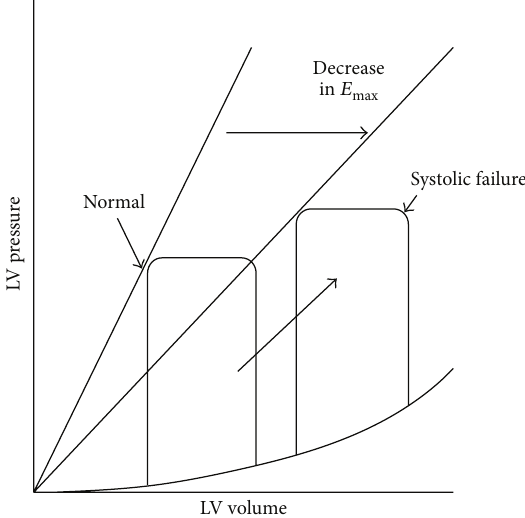
Figure 2: In systolic dysfunction, LV contractile function decreases and 𝐸 max gets smaller. Meanwhile, the end-diastolic pressure- volume relationship shifts downwards rather than remaining unchanged. To maintain cardiac output, the pressure-volume loop shifts right due to increase in preload. Therefore, the LV pressure- volume loop operates on the steep part of the end-diastolic pressure- volume curve, consequently causing end-diastolic pressure to rise. LV: left ventricular.